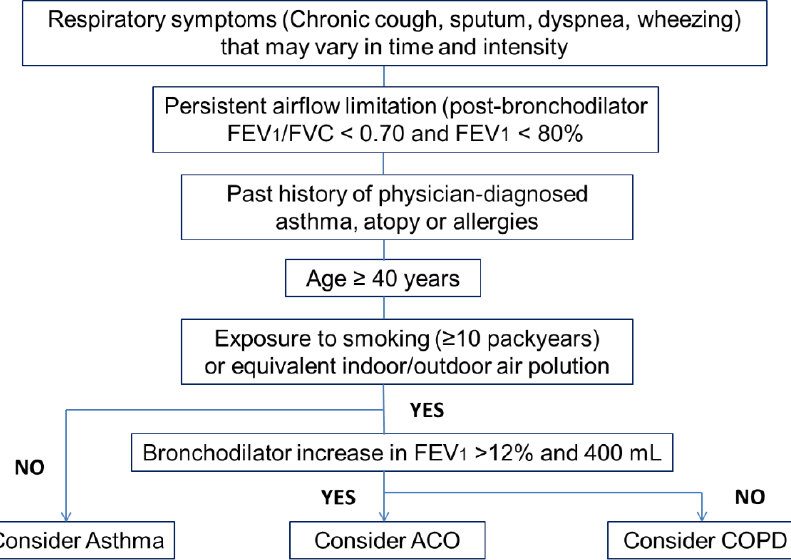
Figure 1. Flow-chart for diagnosing asthma-COPD overlap. ACO: asthma COPD overlap; COPD: chronic obstructive pulmonary disease; FEV1: forced expiratory volume in one second; FVC: forced vital capacity.